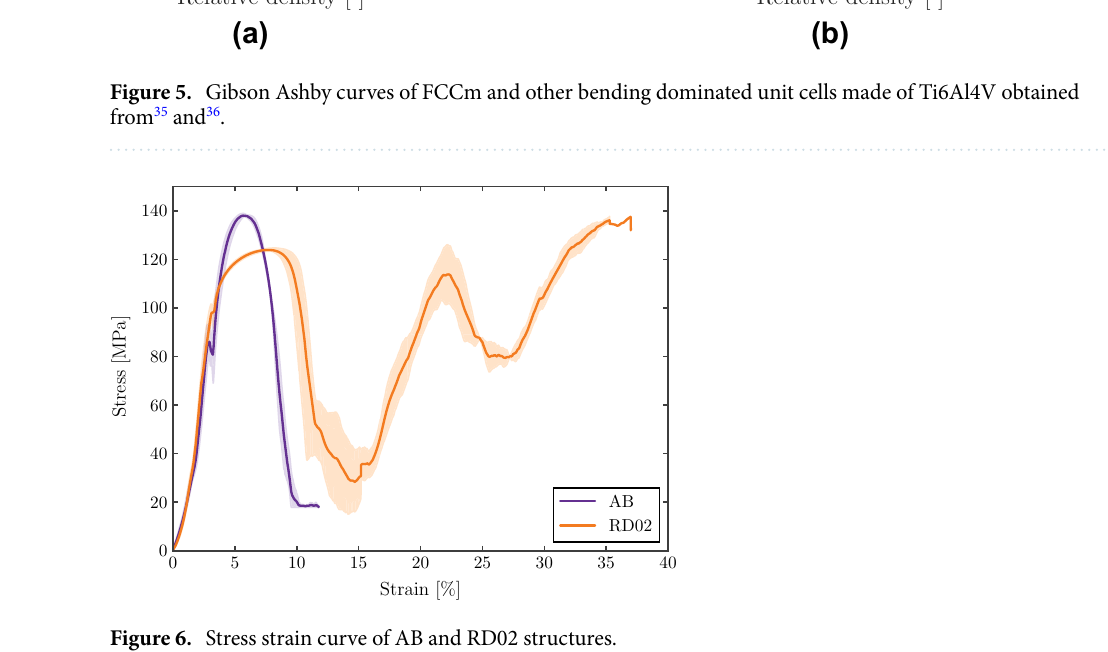
Figure 6. Stress strain curve of AB and RD02 structures.